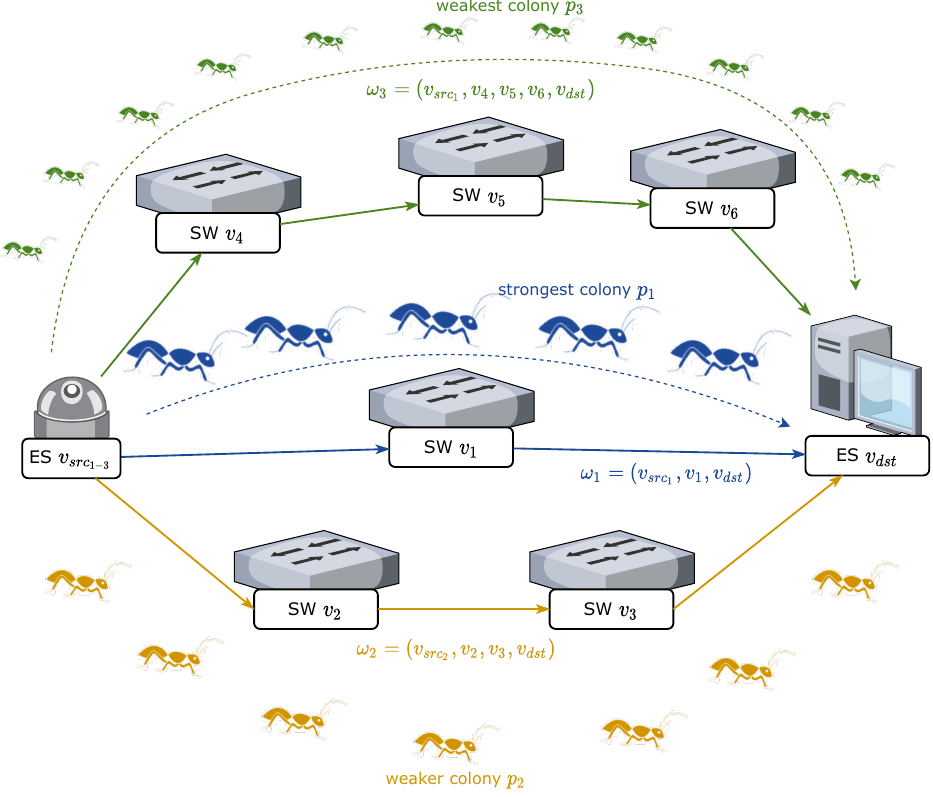
Figure 9. A sample procedure of the AACO algorithm solving the non-TT route assignment